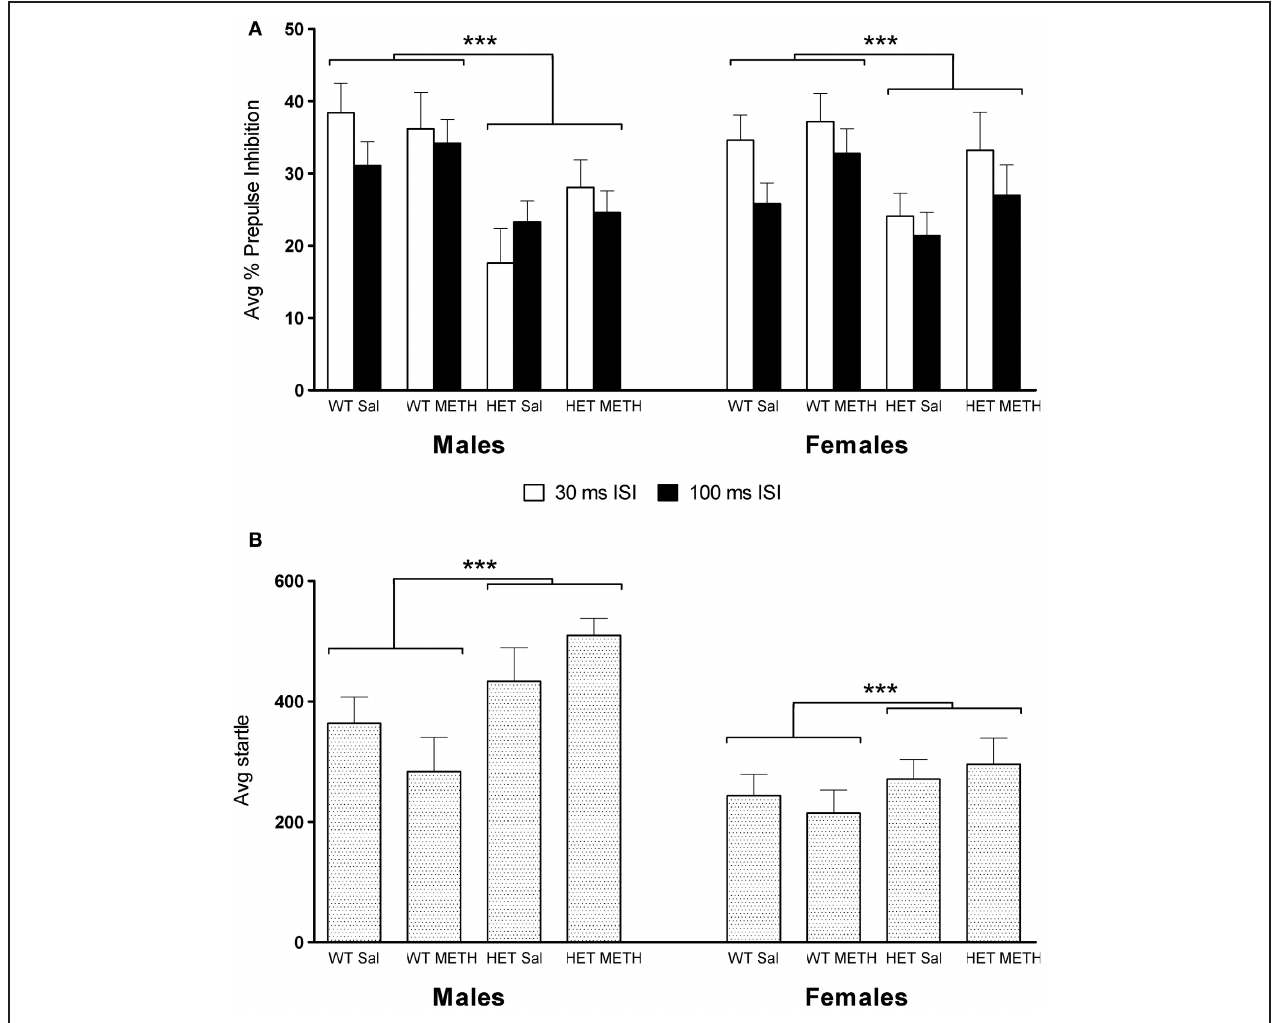
FIGURE 2 | PPI and startle reflex at baseline during saline challenge sessions. (A) Average PPI across all four PP intensities was significantly lower in BDNF HETs compared to WT controls. This effect was seen at both